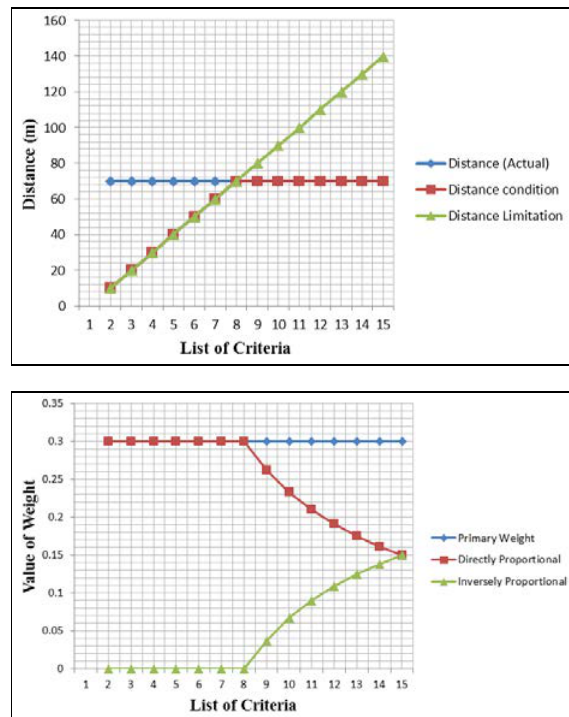
Figure 5. (Above) Fixed Actual Distance Vs Increase Distance Limit. (Below) Secondary Weights as the result of trend of Distance under